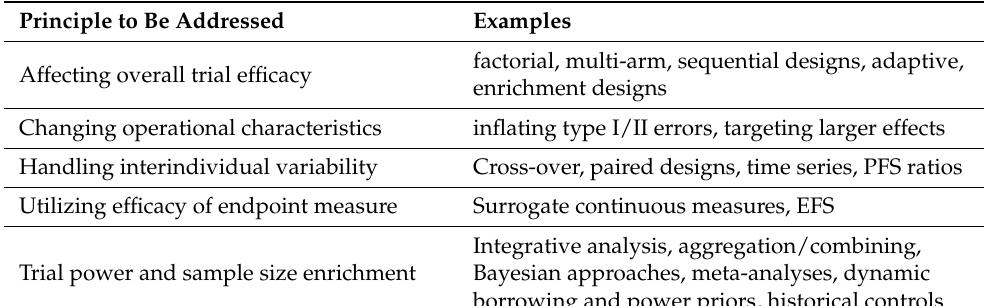
Table 1. General principles affecting sample